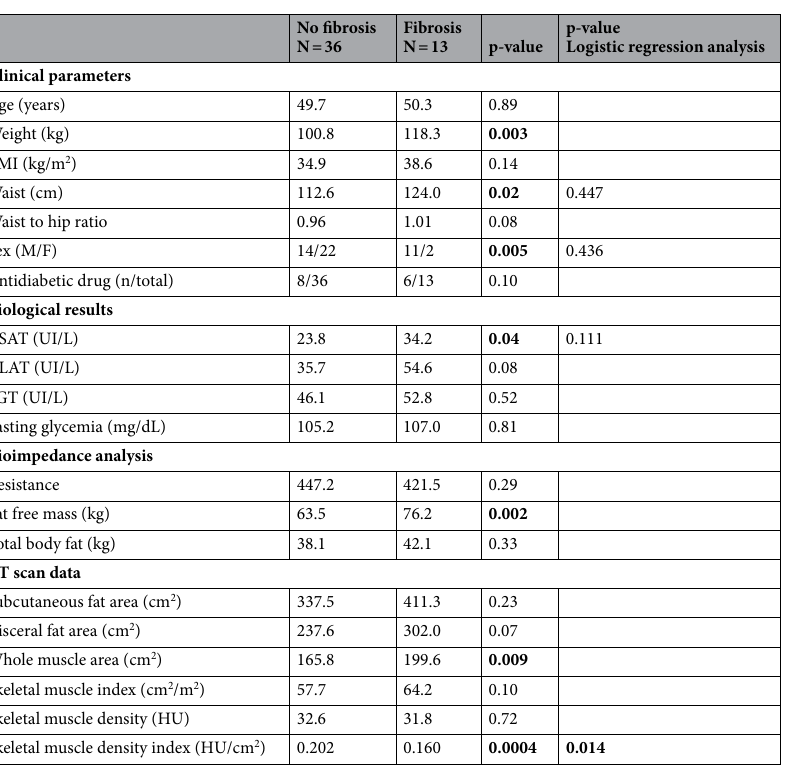
Table 4. Key characteristics of liver fibrosis. Results are given as mean value (and compared with a bilateral Student-t-test). Number of patients are compared with a chi-squared test. All significant parameters from the univariate analysis (except for collinear values) included in the logistic regression analysis are reported in the last column. ASAT aspartate aminotransferase, ALAT alanine aminotransferase, BMI body mass index, γGT γ-glutamyl transferase, HU Hounsfield unit. Significant differences are presented in